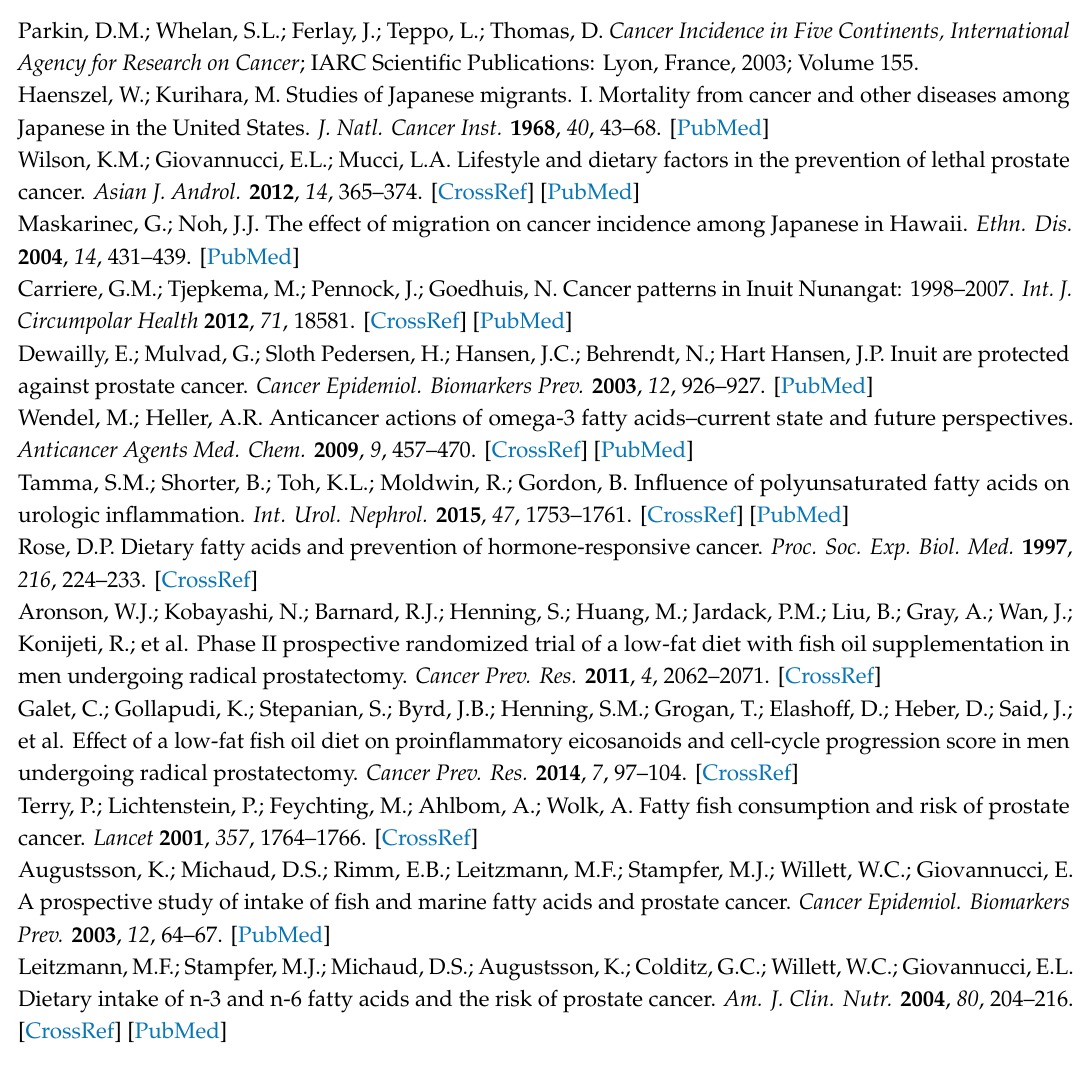
Table S1: Characteristics of excluded and included participants. Table S2: Correlations between fatty acid intake, fatty acid profiles of RBC membranes, and of prostate tissue. Figure S1: Distribution of eicosapentaenoic acid (EPA) level in prostate tissue. Figure S2: Schematic representation of long-chain polyunsaturated omega-6 and omega-3 fatty acids